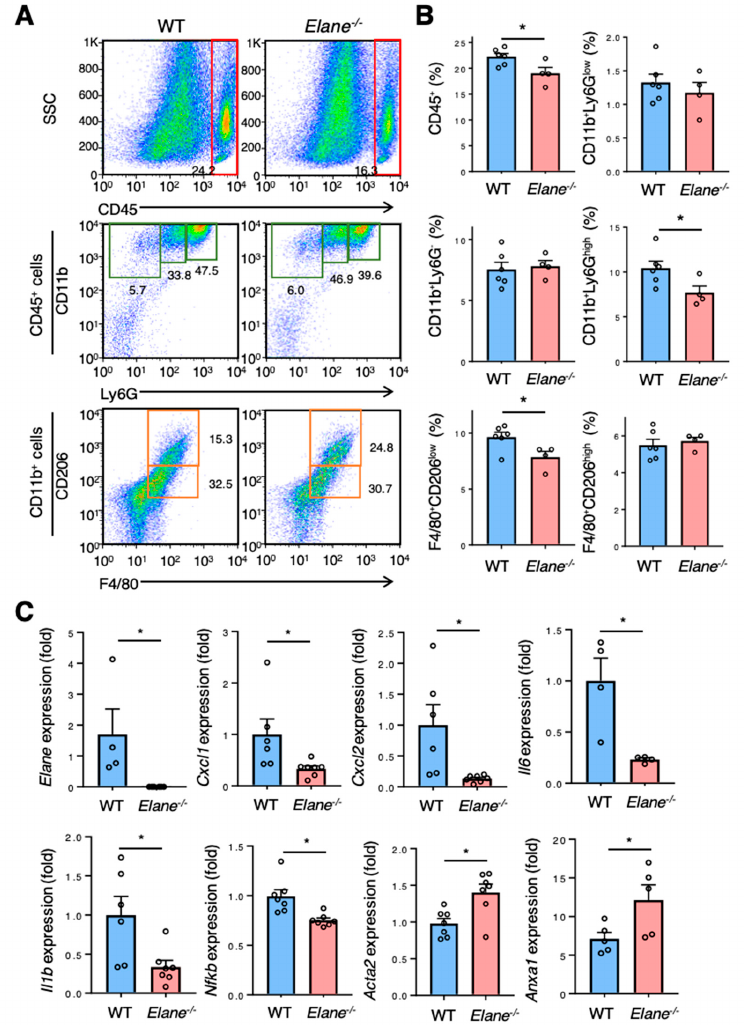
Figure 3. NE deletion suppressed excessive inflammation post-MI. ( A ) Representative flow cyto- metric plots showing CD45 + leucocytes, CD11b + Ly6G low monocytes, CD11b + Ly6G - macrophages, CD11b + Ly6G high neutrophils, CD206 - F4/80 + pro-inflammatory macrophages, and CD206 + F4/80 + anti-inflammatory macrophages in WT and Elane − / − hearts on day 3 post-MI. ( B ) Quantification of each inflammatory cells as a percentage of live cells from WT and Elane − / − hearts on day 3 post-MI. Results are presented as mean ± SEM, n = 4–6 each, * p < 0.05. ( C ) mRNA expression of inflammatory, anti-inflammatory, and fibrotic markers in hearts from WT and Elane − / − mice on day 3 post-MI. Results are presented as mean ± SEM, n = 6–8 each, * p <